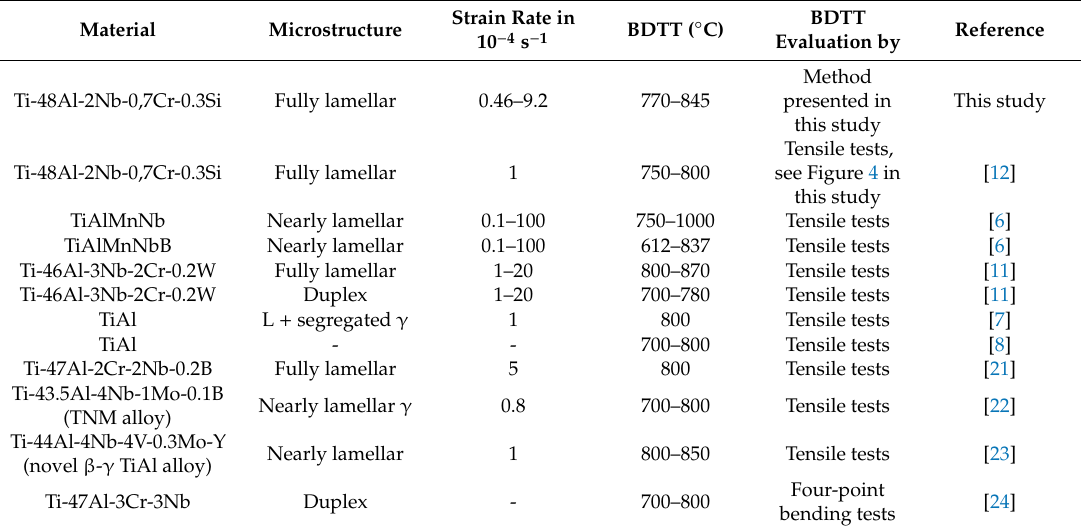
Table 4. BDTTs of TiAl Alloys for Di ff erent Strain